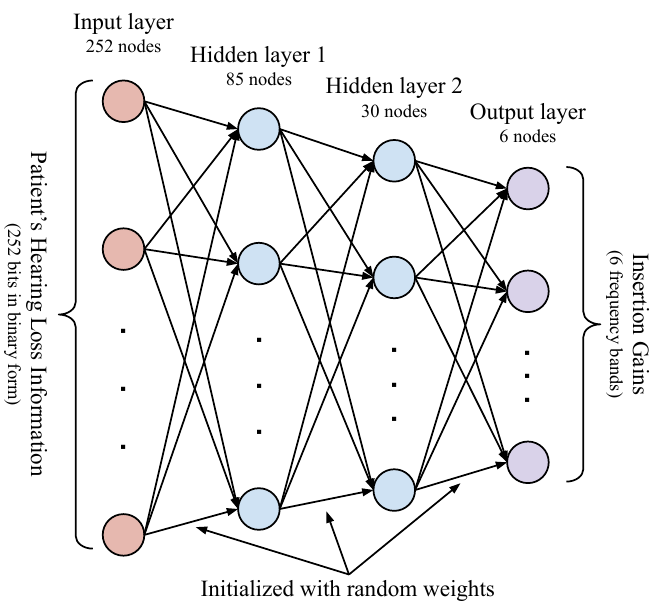
Figure 5. Multilayer Perceptron Neural Network (MLP-NN)